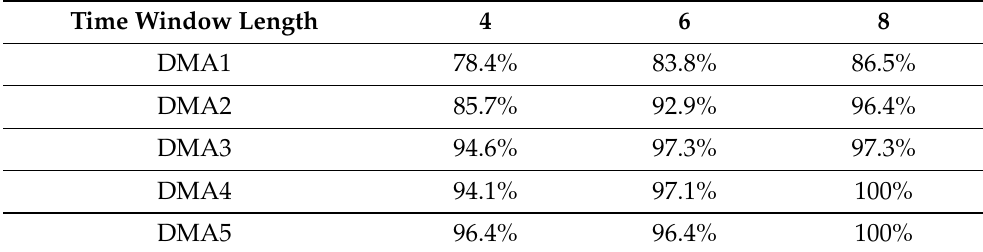
Table 4. Recall rate in different DMAs with different time windows.